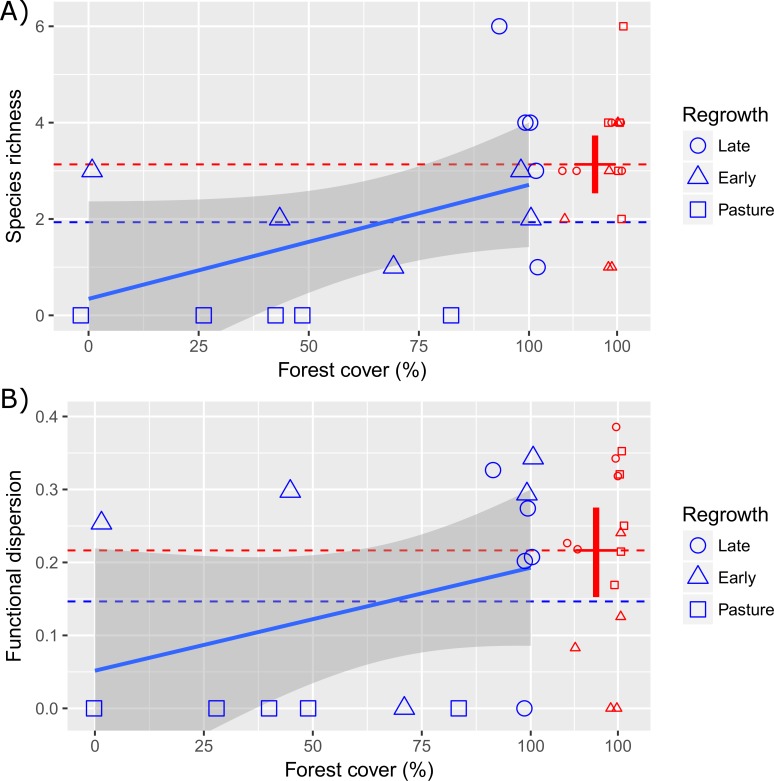
Mammal diversity in Amazon regrowth forests.Patterns of terrestrial mammal species richness and functional dispersion surrounding lowland Amazon small-holdings. Showing the percentage forest cover within a 50 meter radius of 30 camera-trap stations used to record the presence of eight mid to large-bodied terrestrial mammal seed dispersers. Differences in richness and functional dispersion obtained from camera-trap videos taken in three regrowth classes (blue symbols, N = 5 sites each) compared with paired control sites (red symbols). Control sites are moved to the right along the x axis for clarity. Solid red crosses represent mean (horizontal bar) and 95% confidence limits (vertical line) of the 15 control site values estimated via nonparametric bootstrap. Horizontal dashed lines show mean values (regrowth and controls, red and blue respectively). Solid blue line shows the linear trend and 95% confidence intervals (grey shading).